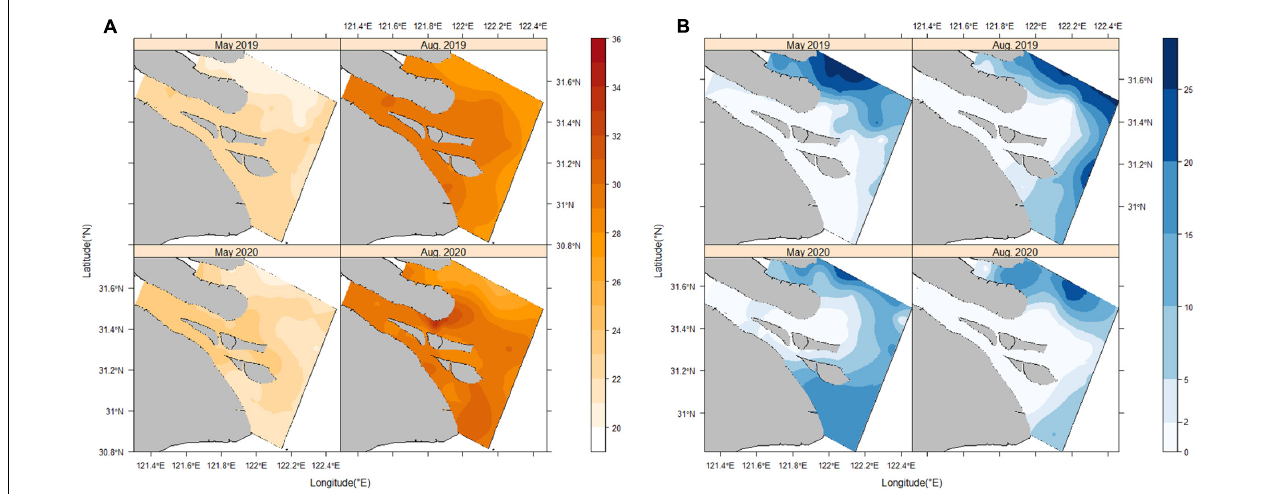
FIGURE 4 | (A) Distribution patterns of the sea surface temperature for each cruise. (B) Distribution patterns of the sea surface salinity for each cruise in the study area.